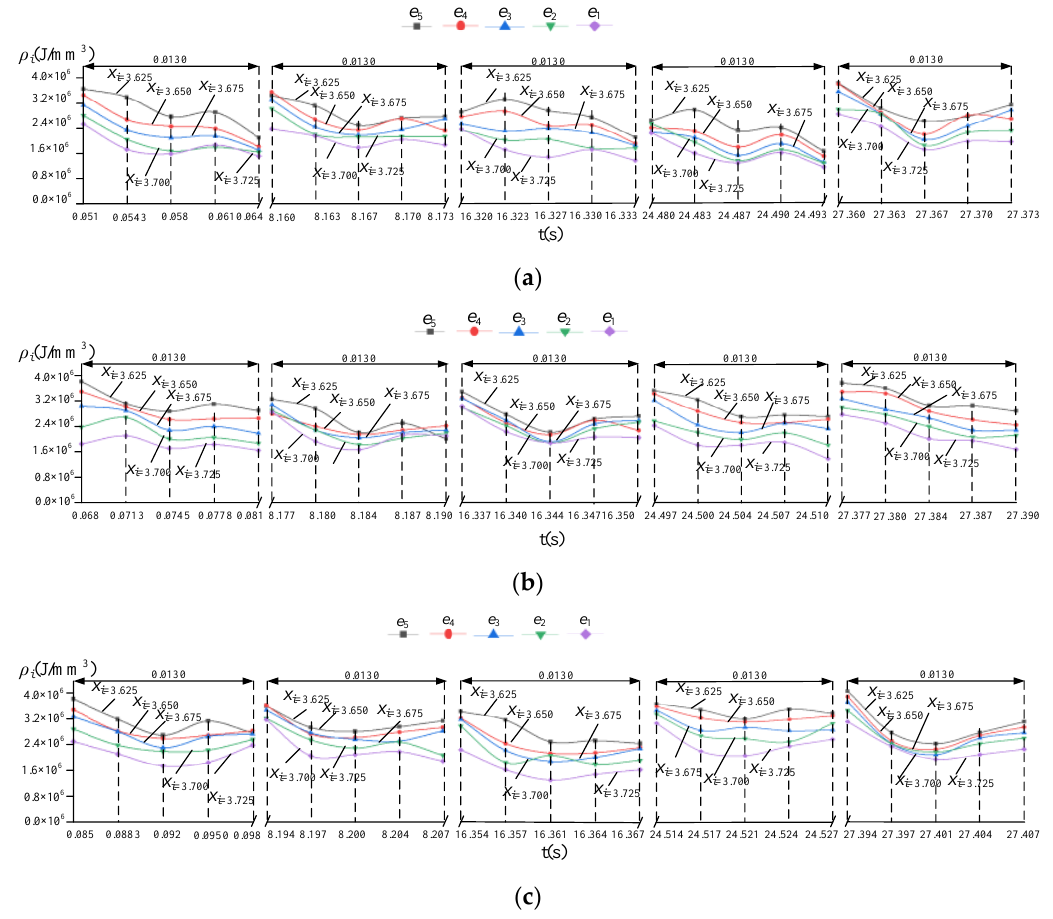
Figure 10. Instantaneous friction and wear energy density on the tool flank of scheme 2 ( y i = 6.700 mm): ( a ) tooth 1; ( b ) tooth 2; ( c ) tooth 3.